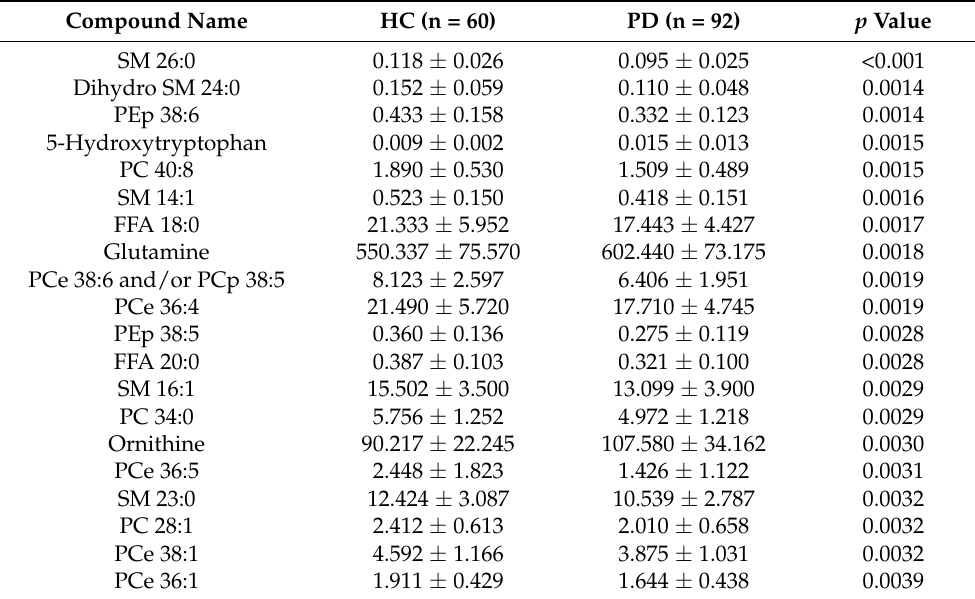
Figure 1. Orthogonal partial least squares-discriminant analysis (OPLS-DA) analysis between the healthy controls (HC, n = 60) and patients with Parkinson’s disease (PD) group (n = 92). ( A ) Orthogonal partial least squares discriminant analysis (OPLS-DA) demonstrates a separation of metabolites between two groups (R 2 Y = 0.22, Q 2 = 0.15). R 2 Y, cumulative variation in the Y matrix; Q 2 , predictive performance of the model. ( B ) Top 30 metabolites with variable importance in the projection (VIP) score > 1.0 indicating their contribution to the classification in the OPLS-DA model. C: ceremide; LPE: lysophosphatidylethanolamine; PC: phosphatidylcholine; PCe: phosphatidylcholine-ether; PCp: phosphatidylcholine- plasmalogen; PEp: phosphatidylethanolamine-plasmalogen; SM: sphinogomyelin. Table 2. Significantly changed levels of plasma metabolites in the patients with Parkinson’s disease (PD) compared to the healthy controls (HC).